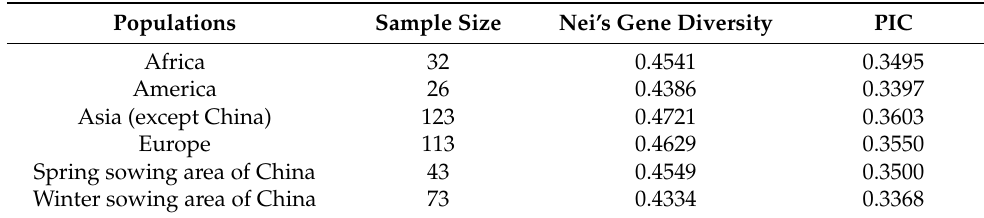
Table 4. Genetic diversity of 410 faba bean accessions based on geographical origin. Populations Sample Size